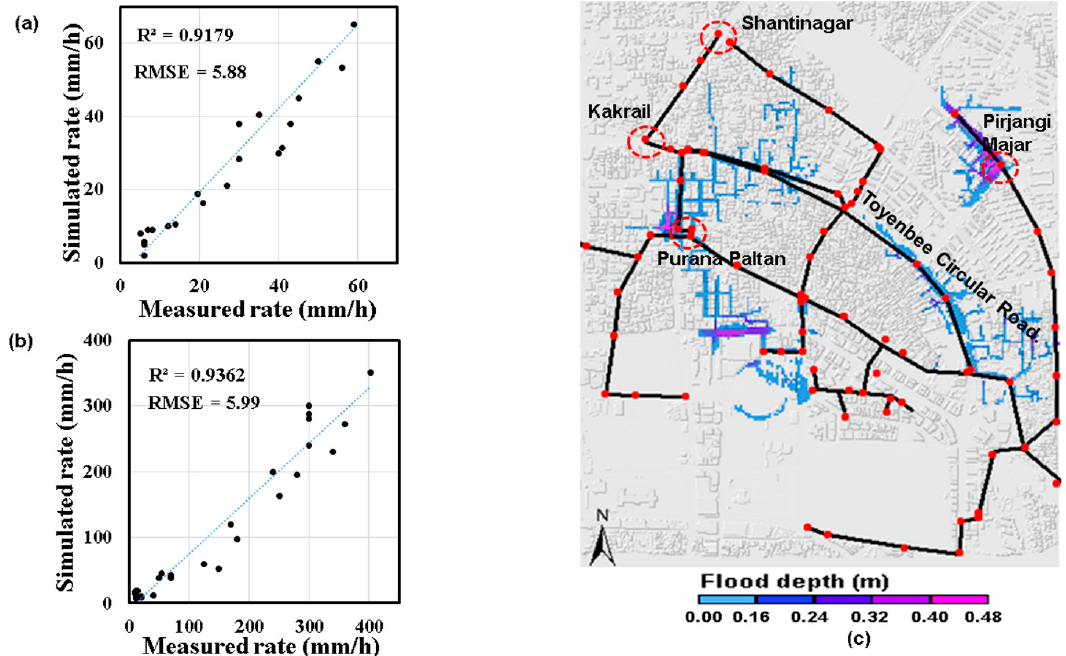
Figure 7. ( a ) Simulated infiltration rates vs. measured infiltration rates for a clay soil; ( b ) simulated infiltration rates vs. measured infiltration rates for a sandy soil; and ( c ) flood depth map without implementing infrastructure.